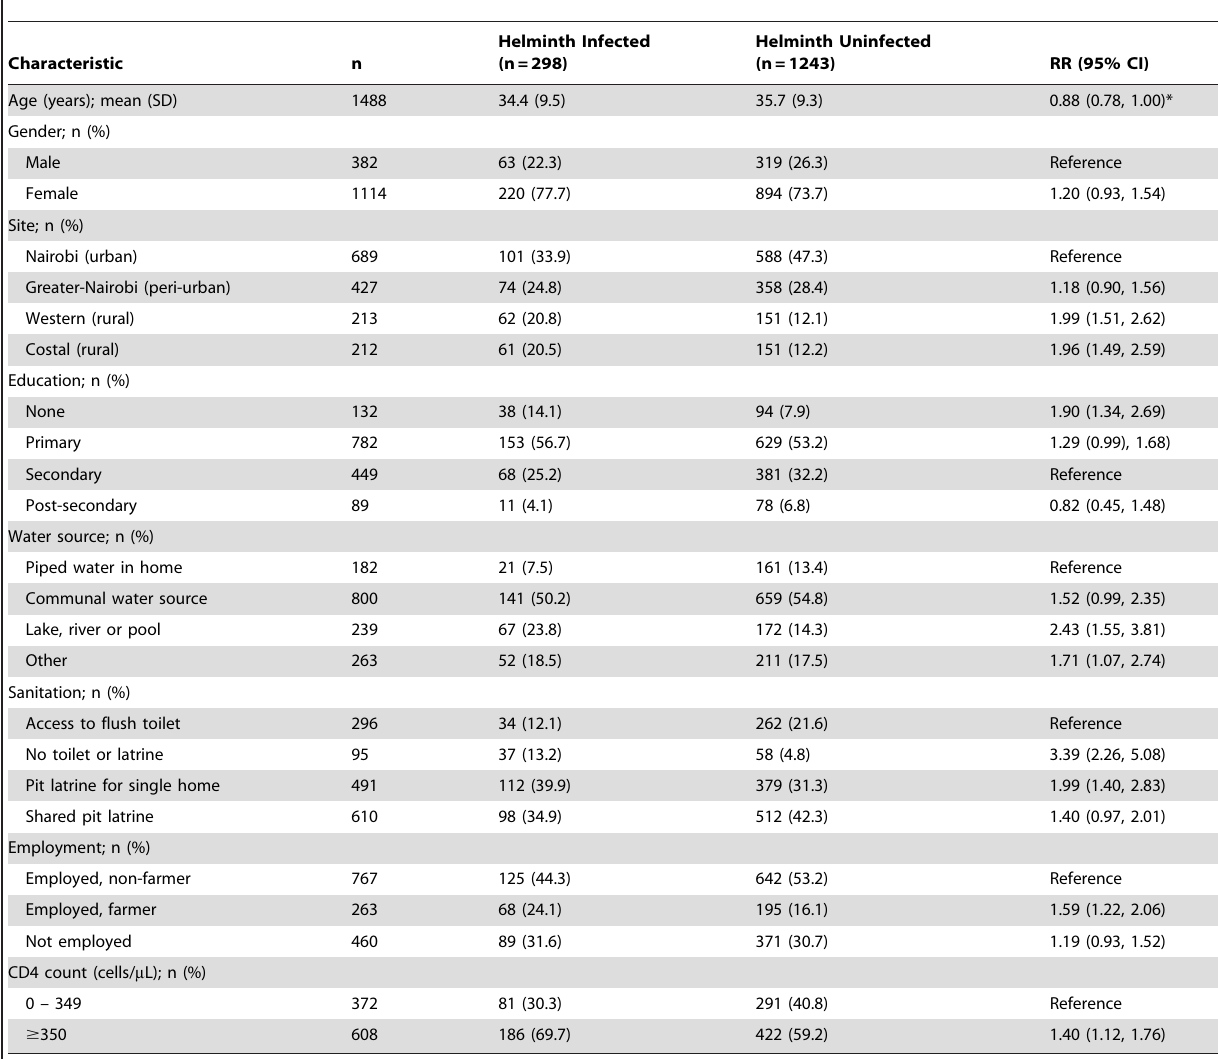
Table 1. Correlates of helminth infection among HIV-1 seropositive adults in